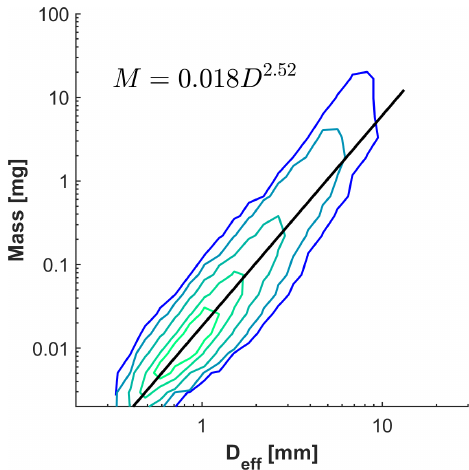
Figure 7. Mass–diameter relationship for all 86285 snowflakes. Contours shown are for the 25th, 50th, 75th, 90th, and 95th per-